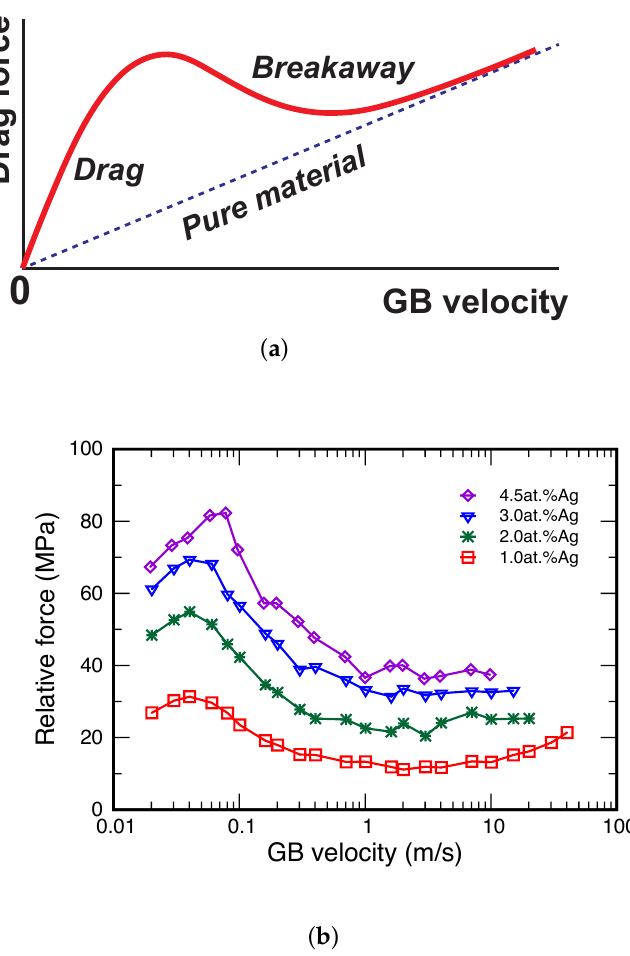
Figure 1. ( a ) Schematic force–velocity diagram according to the classical model of GB solute drag [29,48,49]. The maximum of the drag force separates two kinetic regimes, with the GB dragging the segregation atmosphere at low velocities and breaking away from it at high velocities. ( b ) Driving force for the planar Σ 17 ( 530 )[ 001 ] GB as a function of GB velocity at different alloy compositions is indicated in the key [50]. The GB is driven by an applied shear